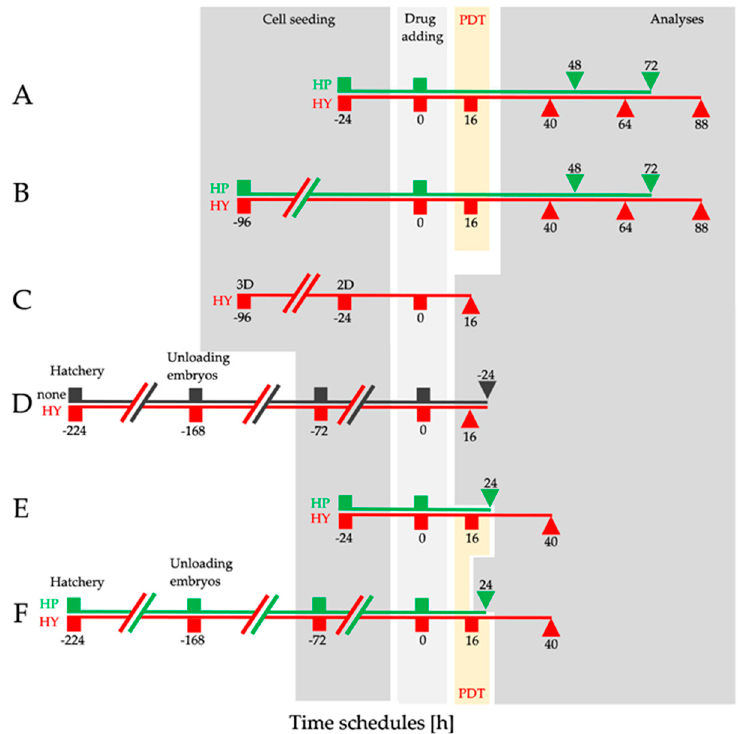
Figure 10. Experimental design. Time schedules A and B : MTT assays in the HY-PDT treatment group were performed 24, 48, and 72 h after PDT. HY was added 16 h before PDT (0 in time schedule). MTT assays on the HP treatment group were performed 48 and 72 h after HP addition (0 in time schedule). Time schedule C : The intracellular HY content was examined 16 h after HY addition. Time schedule D : Histological characteristics of micro-tumors were examined 72 h (0 in grey line—data not shown) and 96 h (24; grey line) after application of cells. HY was detected in experimental micro-tumors 16 h after topical application (red line). Time schedule E and F : Analyses of gene and protein expression were performed in the HY-PDT group 24 h after PDT (40; red line) and in the HP group 24 h after HP addition (24; green line).